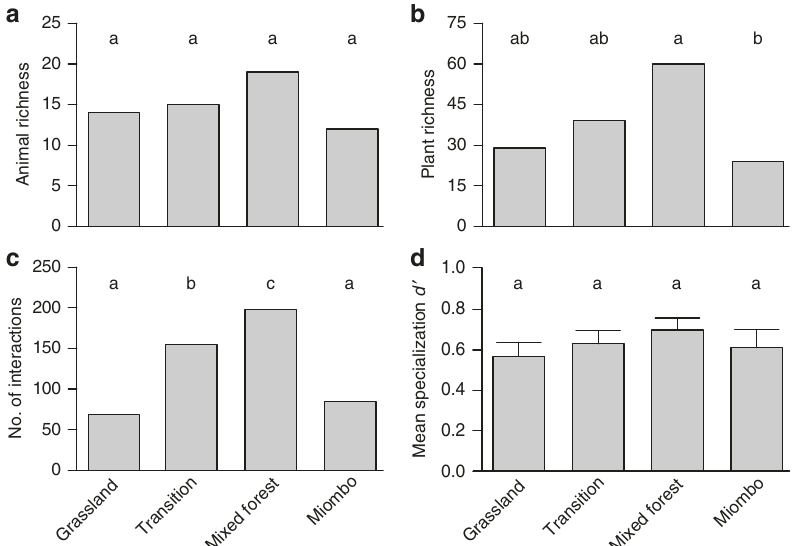
Fig. 4 Network- and species-level descriptors of the interactions from each habitat of Gorongosa. Differences among the main habitats of Gorongosa in terms of a animal species richness, b plant species richness, c number of interactions, d species specialization (mean ± SEM). Different letters indicate statistical pairwise differences: a – c , pairwise G tests (see Supplementary Table 2 for full results); d , generalized linear mixed models (63 observations/ occurrences of 32 animal species in four habitats; Supplementary Table 3 for full